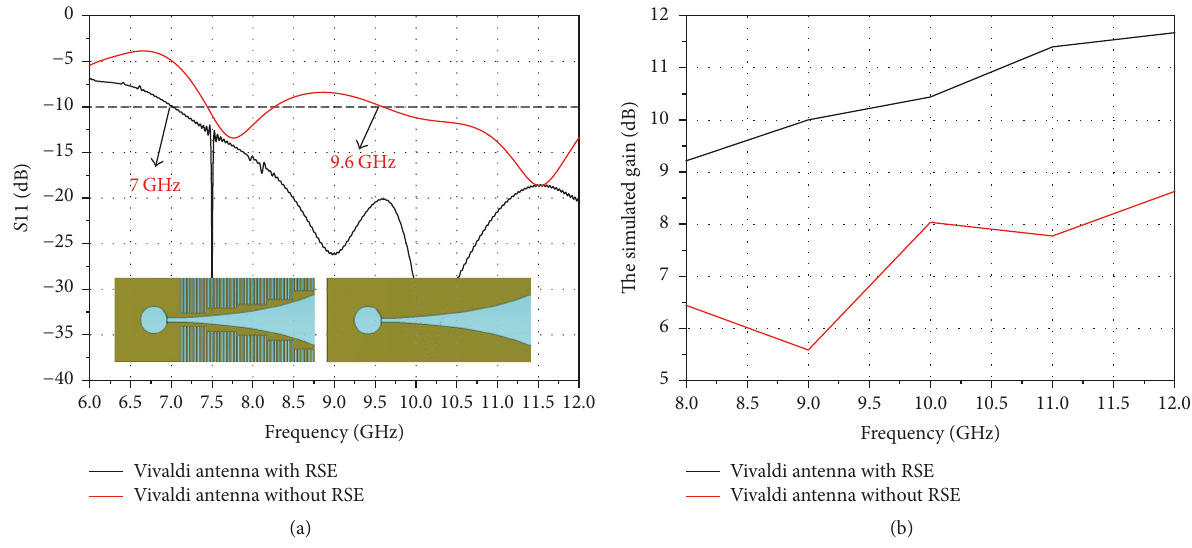
Figure 5: The simulated 𝑆11 and gain for Vivaldi antenna with RSE and Vivaldi antenna without RSE.